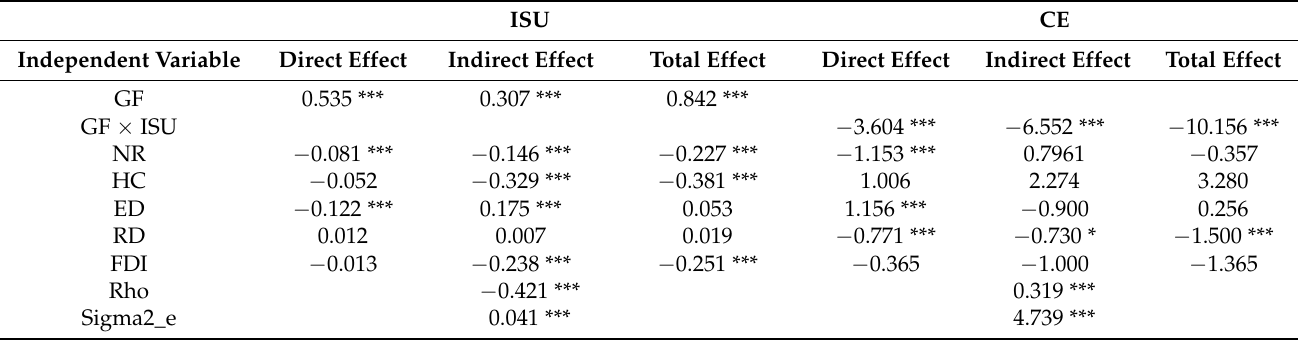
Table 6. Results of the formation mechanism